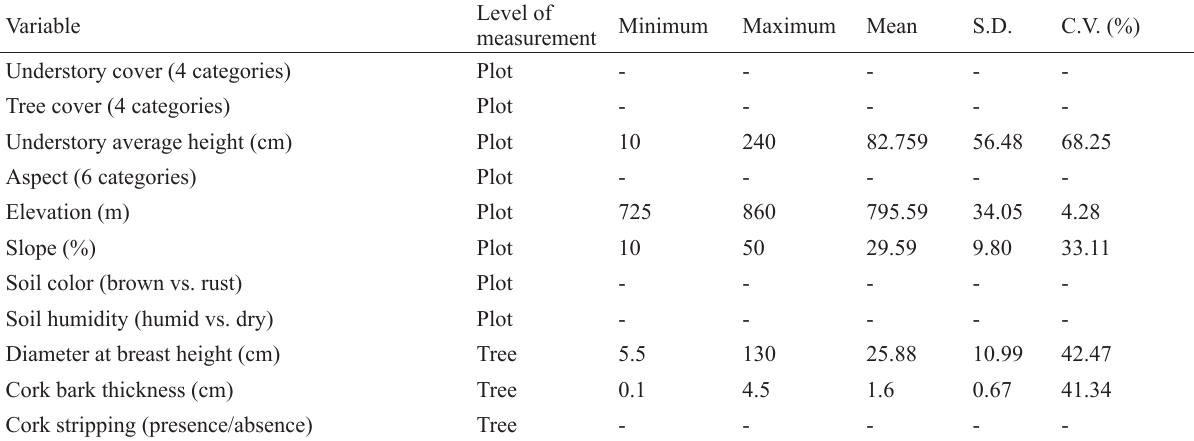
Table 2. Summary of the variable assessed in the study area